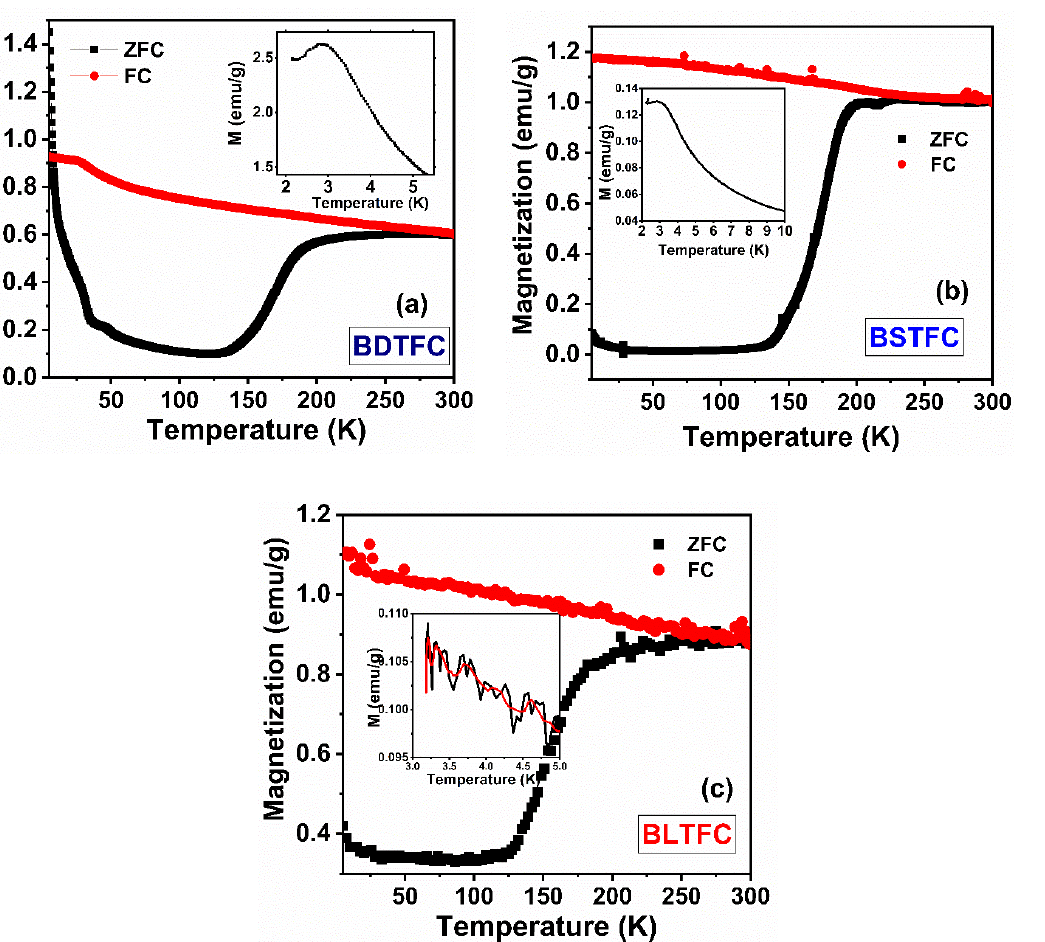
Figure 8. ( a – c ) Temperature dependence of magnetization curves for BSTFC sample measured in the ZFC and FC.